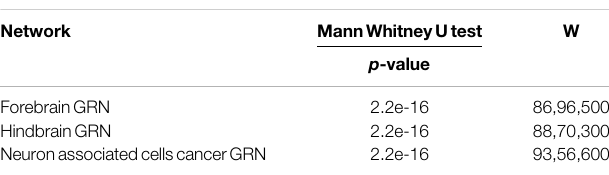
TABLE 3 | Thesigni fi cancetestof CO